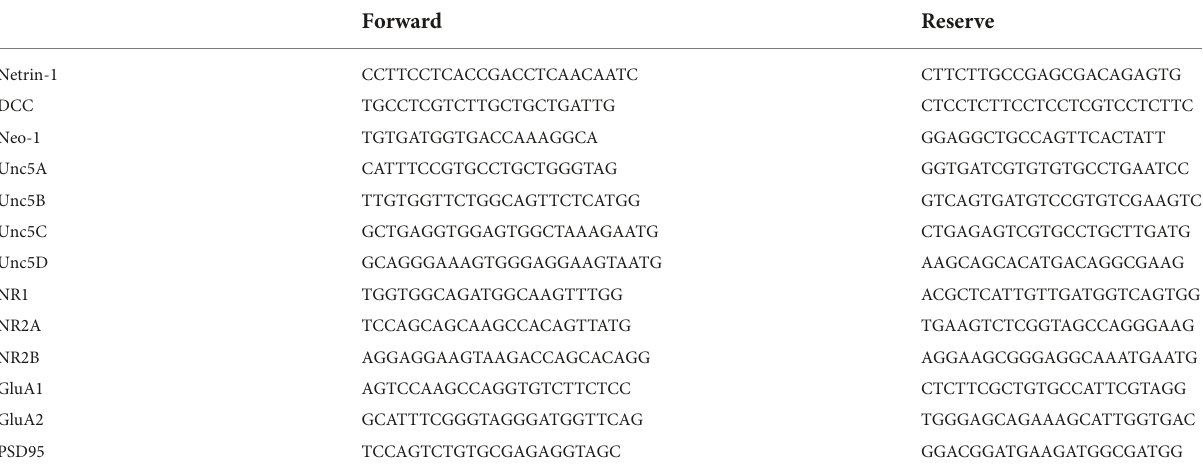
TABLE 1 List of qRT-PCR